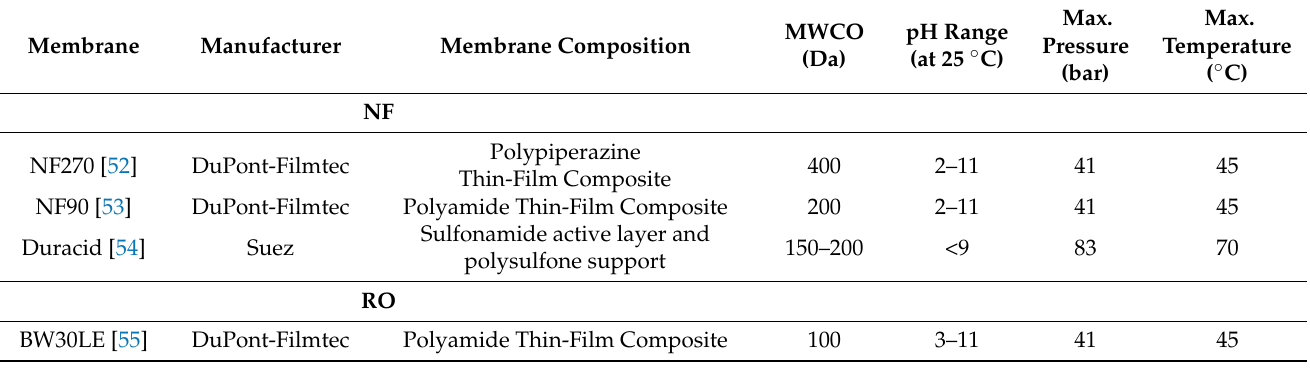
Table 1. The membranes used in this study and their